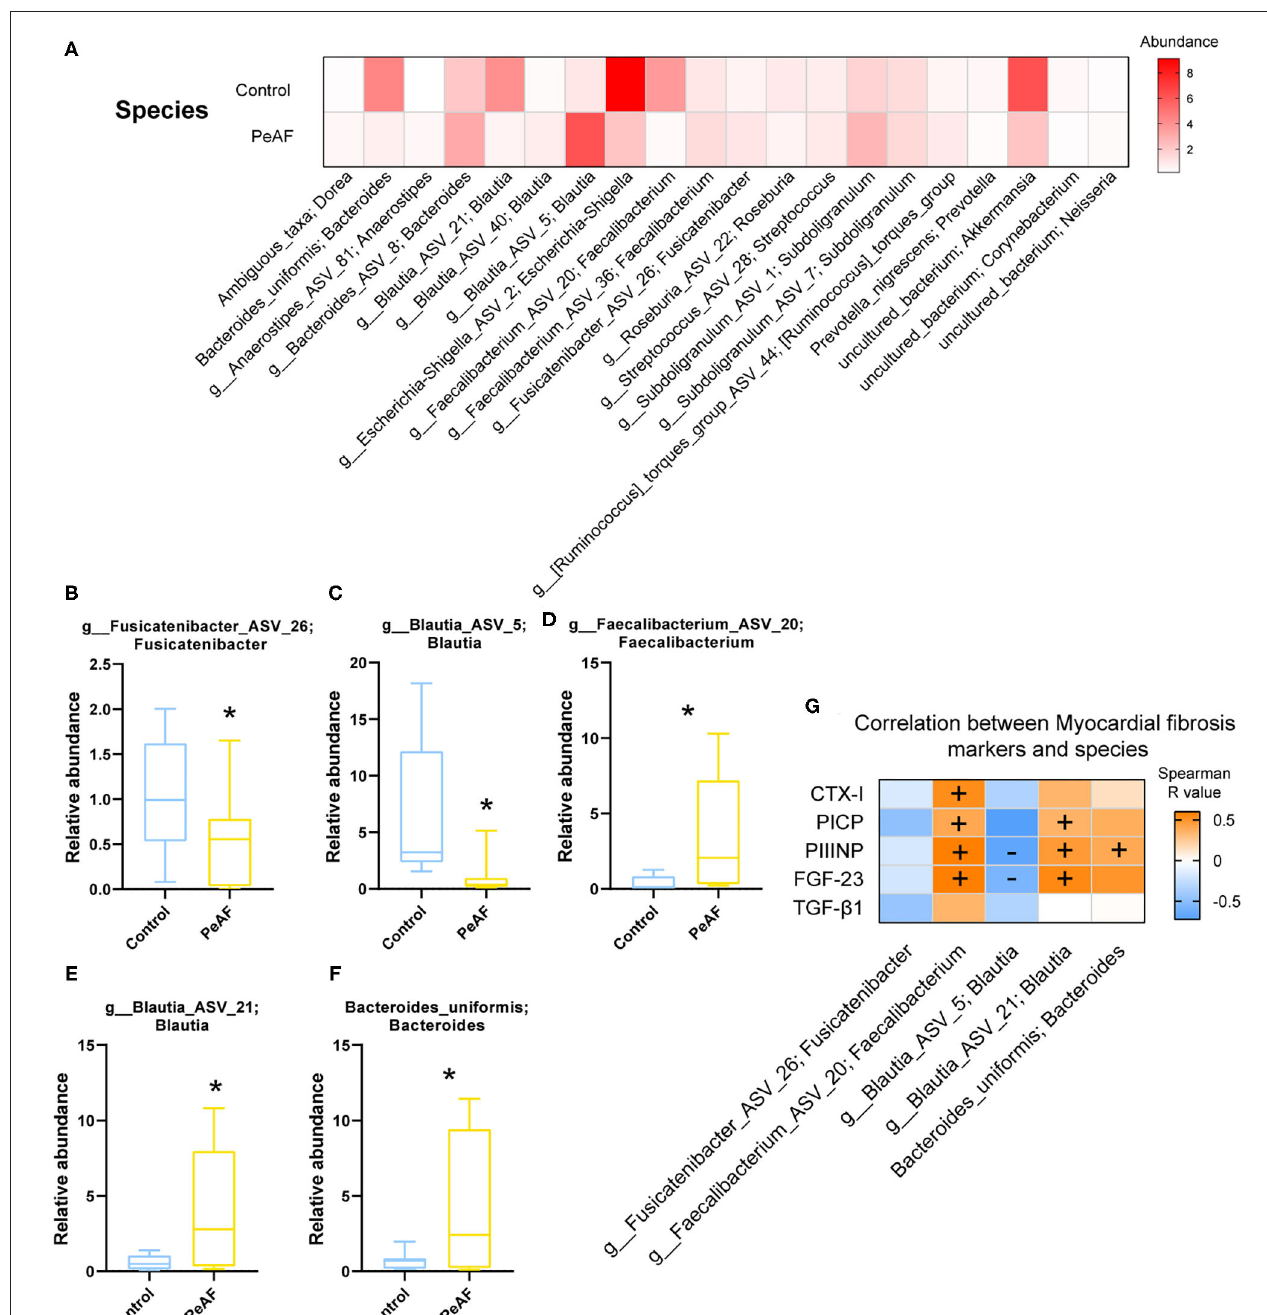
FIGURE 5 | Variations in the abundances in the intestinal flora at the species level. (A) Abundance heat map of the top 20 species; the darker the color is, the higher the abundance level. (B) Relative abundance of g_Fusicatenibacter ASV 26; Fusicatenibacter. (C) The relative abundance of g_Blautia_ASV_5; Blautia. (D) The relative abundance of g_Faecalibacterium_ASV_20; Faecalibacterium. (E) The relative abundance of g_Blautia_ASV_21; Blautia. (F) The relative abundance of Bacteroides uniformis; Bacteroides. *Compared to the control group, p < 0.05. (G) . Correlation analysis between myocardial fibrosis markers and different flora. “ + ” indicates positive correlation (orange), p < 0.05. “-” indicates negative correlation (blue), p < 0.05.